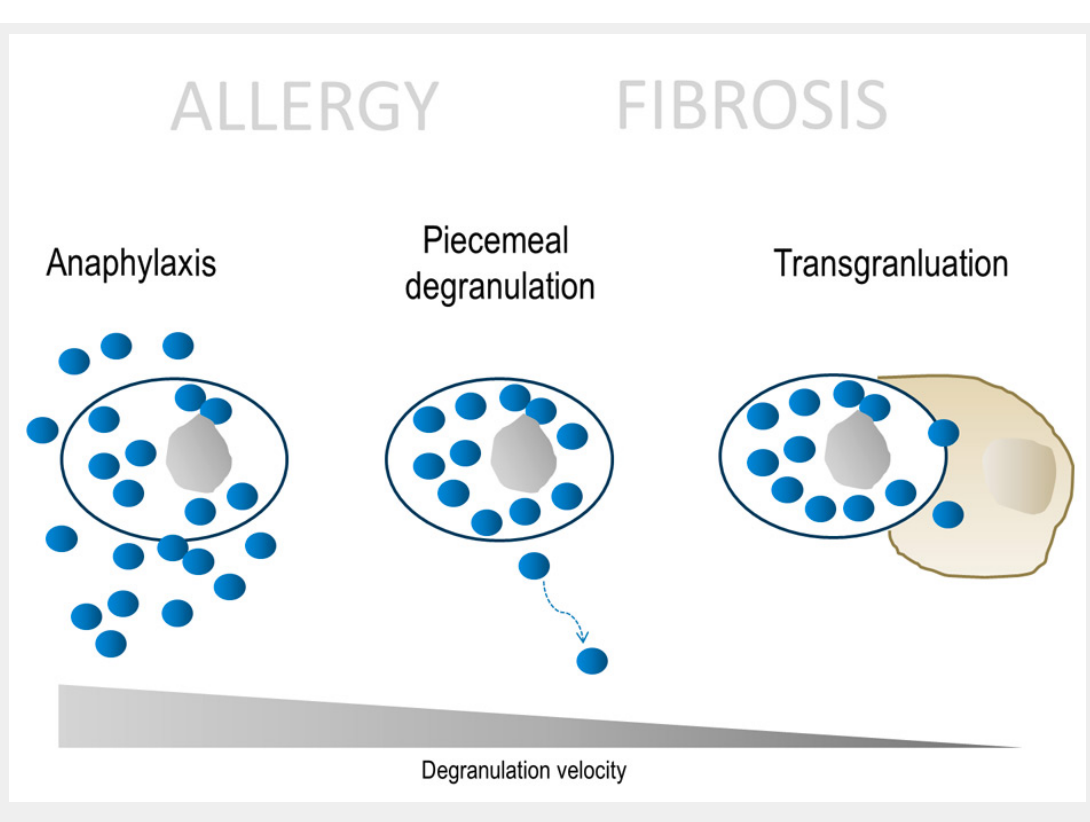
Figure 1 Different forms of degranulation in mast